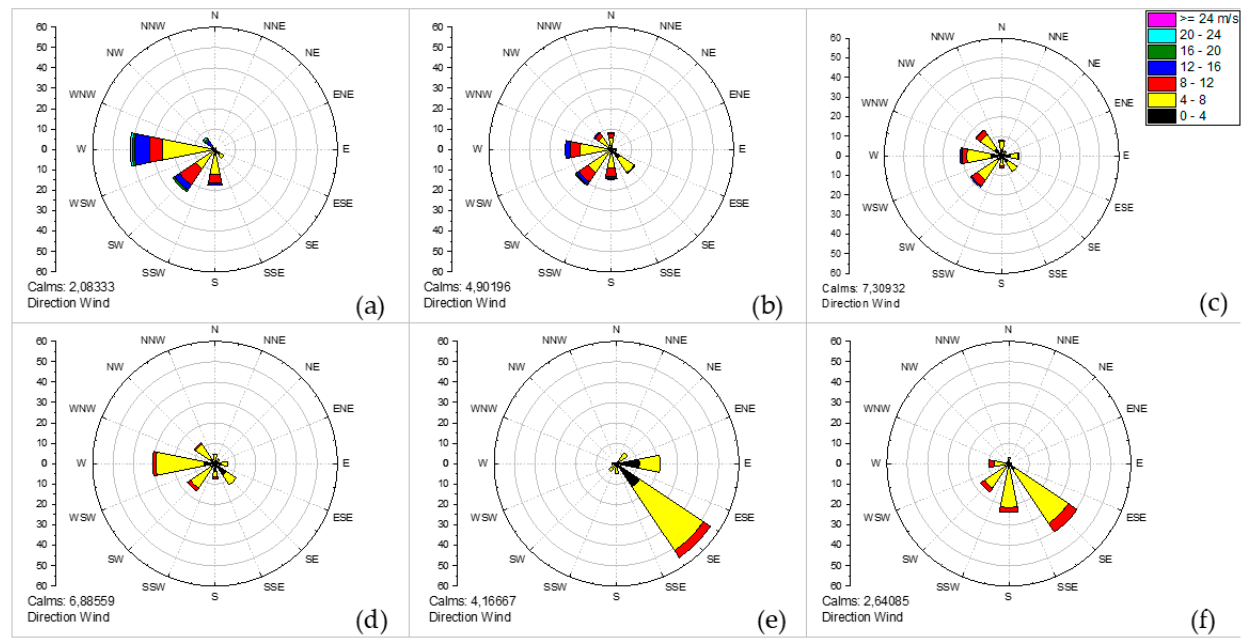
Figure 5. Wind roses for the study period: ( a ) 25 11 1999–06 12 1999; ( b ) 07 12 1999–26 01 2000; ( c ) 27 01 2000–23 05 2000; ( d ) 24 05 2000–19 09 2000; ( e ) 20 09 2000–09 10 2000; ( f )10 10 2000–19 12 2000.